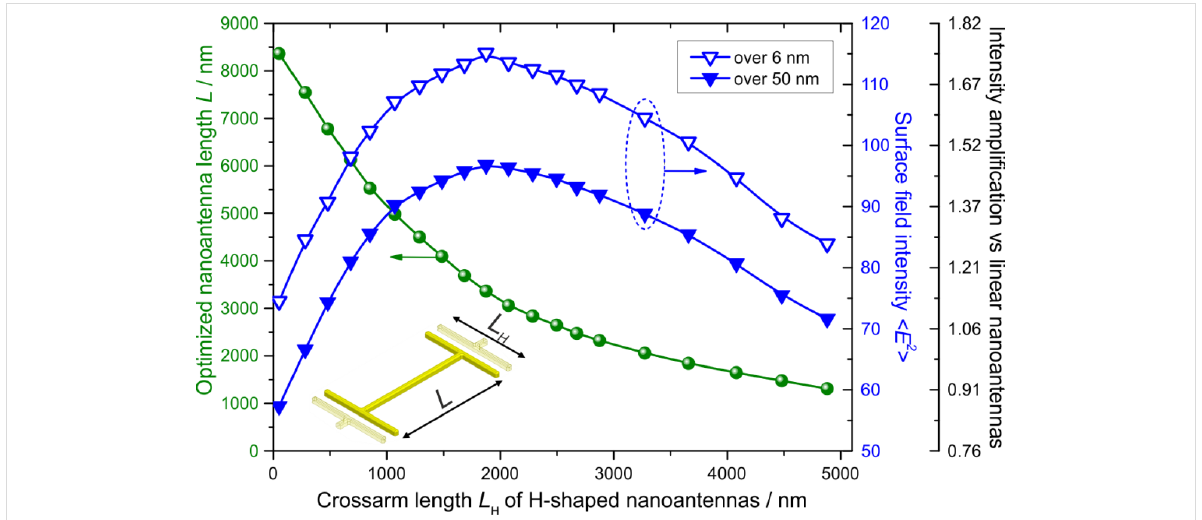
Figure 3: Optimized nanoantenna length L vs the transverse crossarm length L H for H-shaped nanoantennas with the LSPR energy fixed at 190 cm − 1 (circles) and the dependence of the averaged electric field intensity < E 2 > on L H (triangles). The transverse spacing between antennas is chosen to coincide with the wavelength of the first 1st diffraction harmonics: G y = 15380 nm. The rightmost vertical scale represents < E 2 > normalized to that of linear nanoantennas optimized for 190 cm − 1